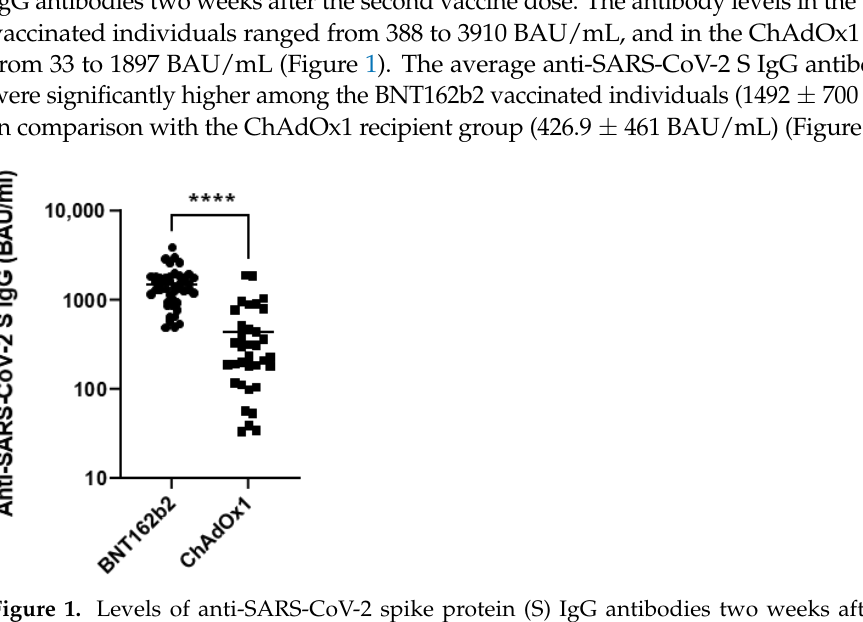
Figure 1. Levels of anti-SARS-CoV-2 spike protein (S) IgG antibodies two weeks after the two ho- homologous doses of BNT162b2 or ChAdOx1 vaccines. ****— p < mologous doses of BNT162b2 or ChAdOx1 vaccines. ****—p<0.001.